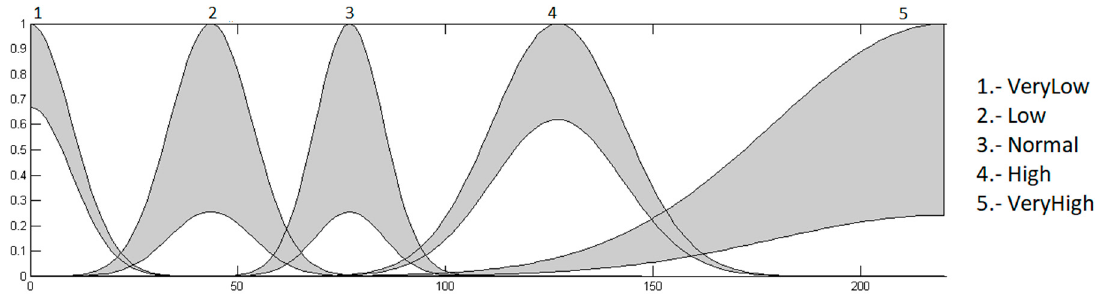
Figure 28. Optimized input age with Gaussian MFs.